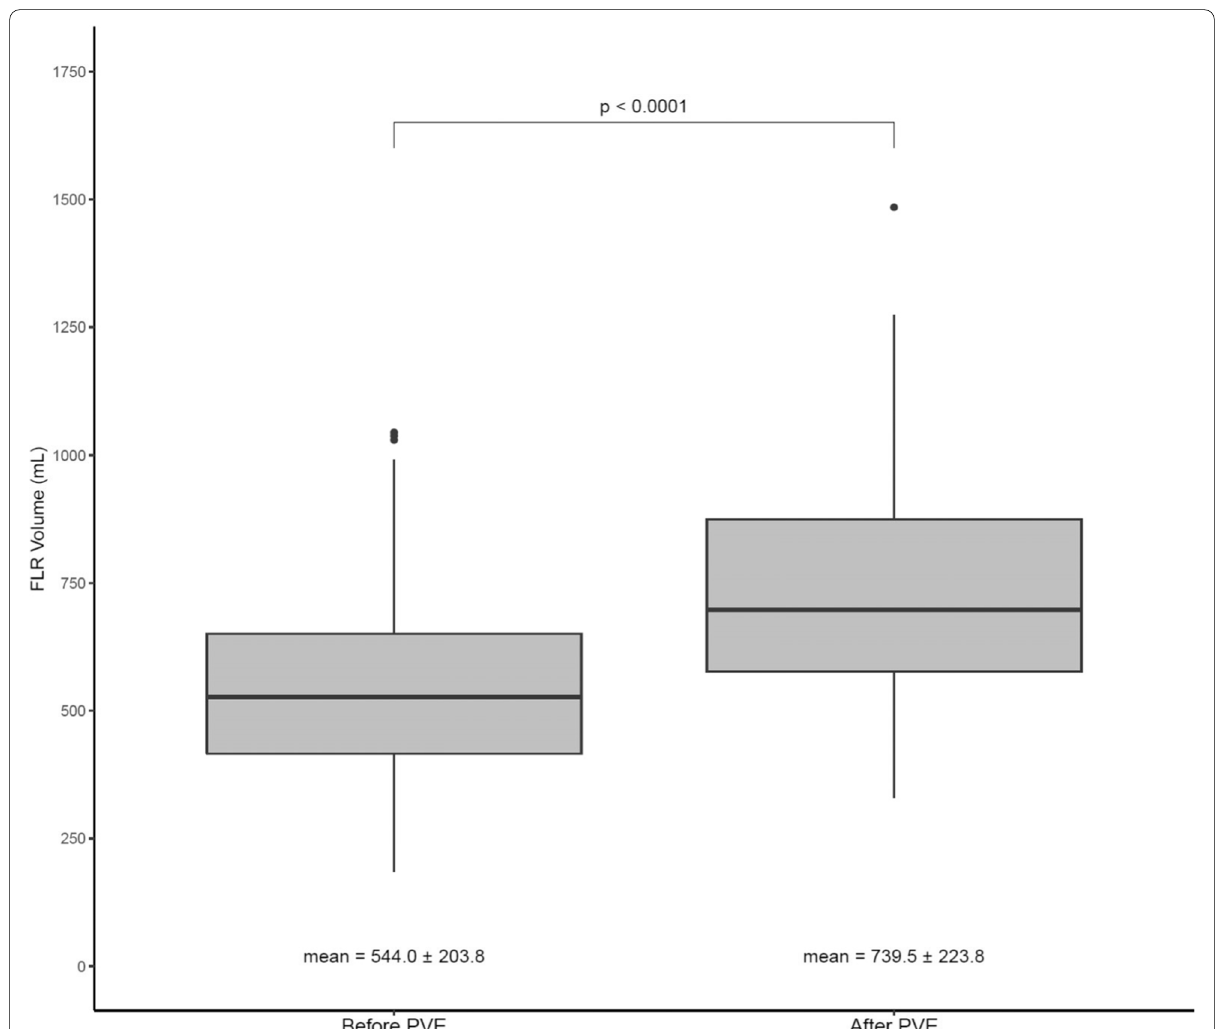
Fig. 4 Mean FLR volume increased from 544.0 statistically significant ( p <